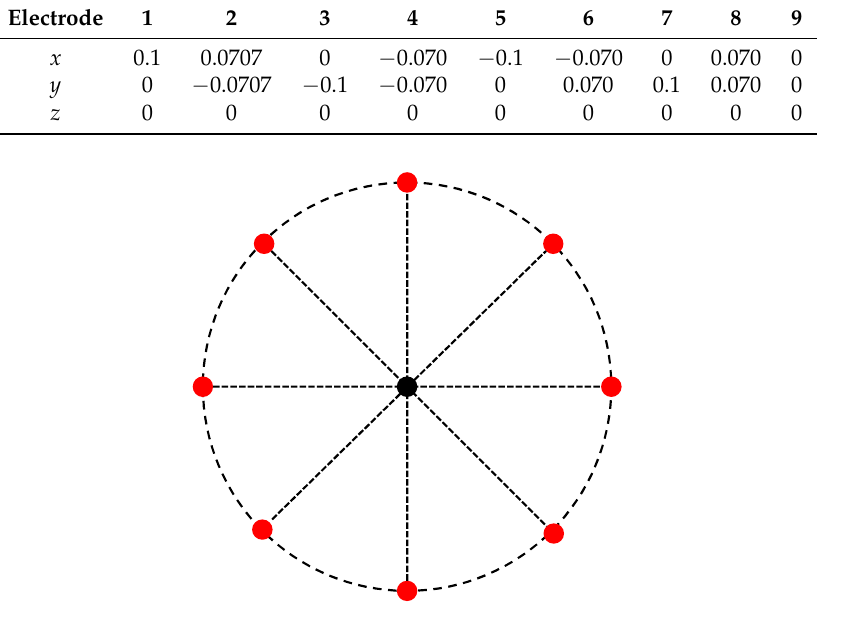
Figure 2. The uniform circular electrode